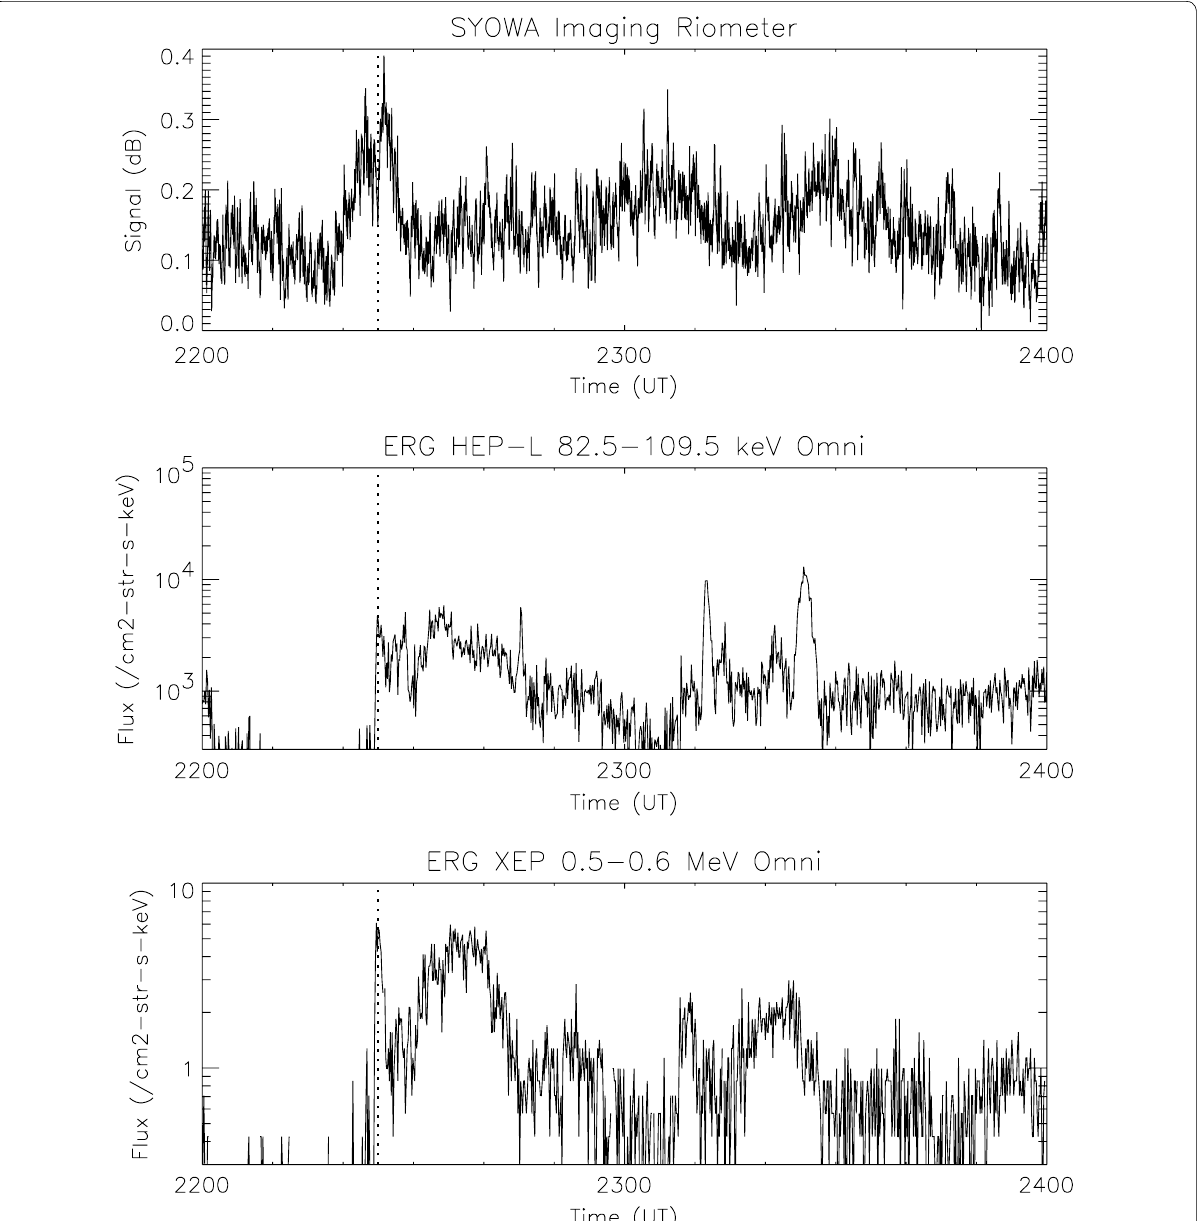
Fig. 3 Cosmic noise absorption event at 2225 UT on June 30, 2017, as observed by the imaging riometer at Syowa Station. The observation frequency was 38.2 MHz. The beam direction is toward the zenith and the beam width is approximately 10°. The data are running averaged by an 8-s window to reduce random noise. The bottom panels show the omnidirectional flux of 82.5–109.5 keV and 0.5–0.6 MeV electrons, as observed by the HEP and XEP instrument of the Arase satellite,